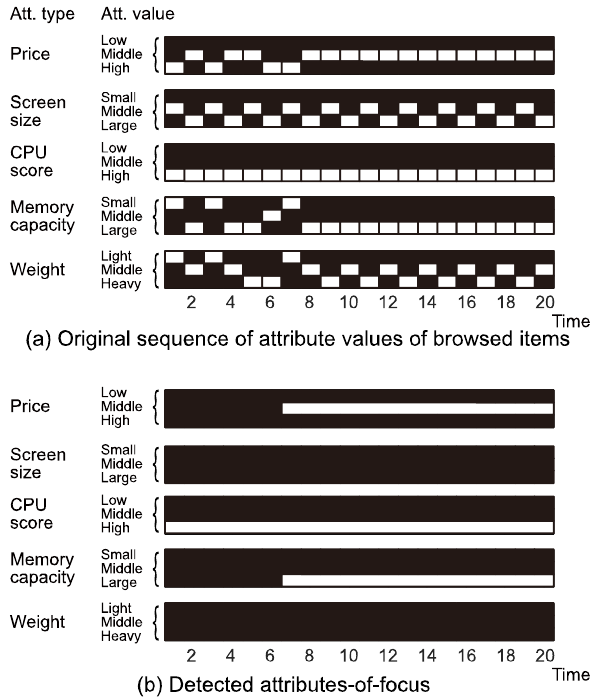
Figure 7. Example of detected AOF. (a) The original sequence of attribute values of browsed items; (b) detected